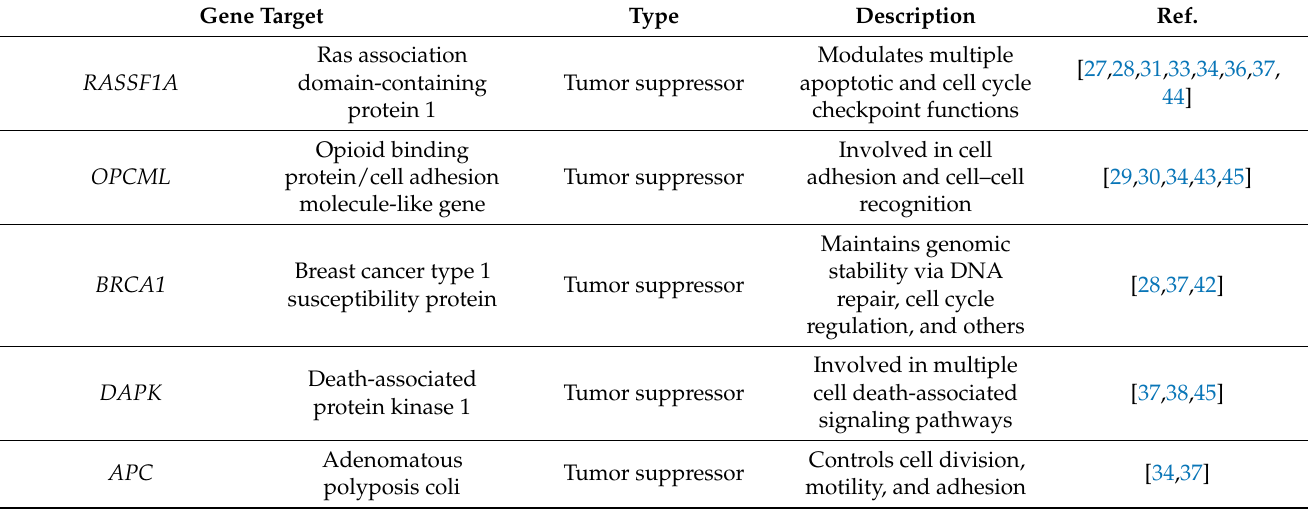
Table 2. Gene targets for methylation analysis on cell-free DNA from patient serum or plasma. Gene Target Type Description